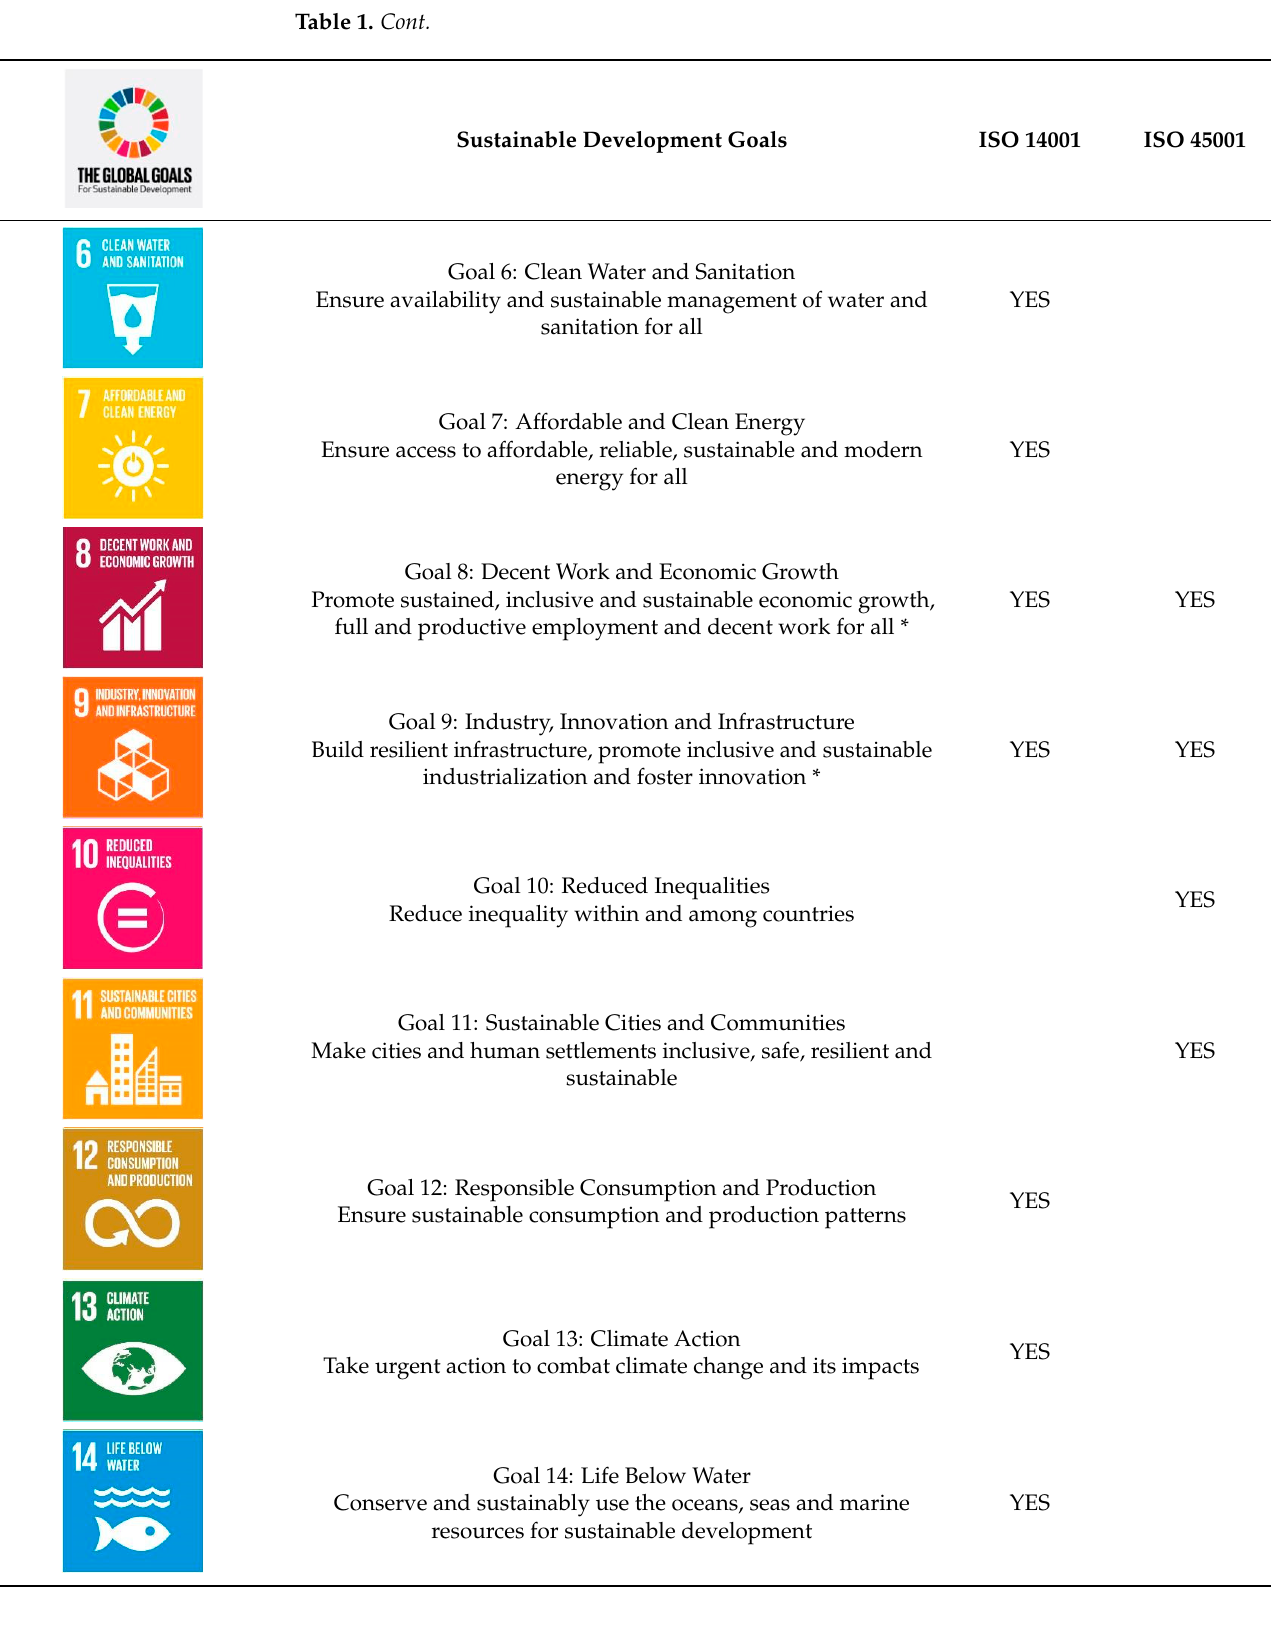
Table 1. ISO 14001 and 45001 contribute to the following Sustainable Development Goals (Adapted Table 1. Cont. with permission from [20] by the